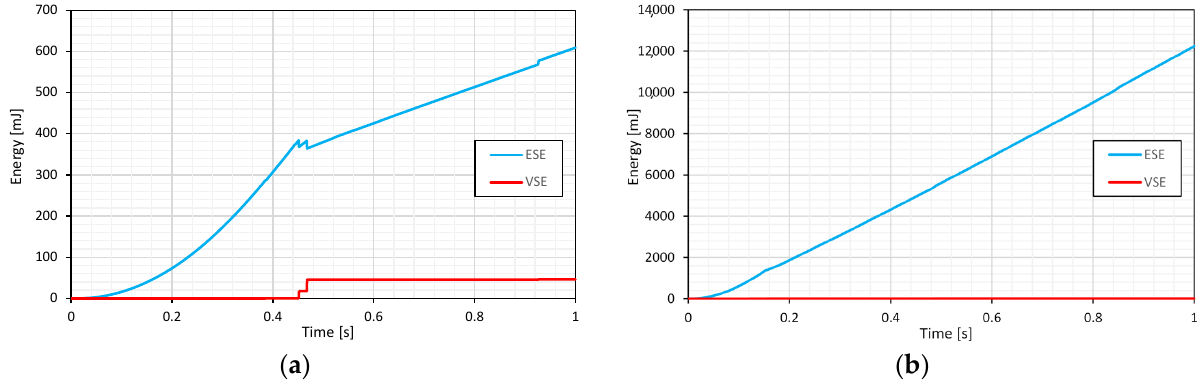
Figure 21. Total elastic and viscous damage energy for ( a ) reduced integration for 15 mm cover with 15% residual compressive stress; ( b ) reduced integration for 70 mm cover with 80% residual compressive stress cover for the double-lap test.